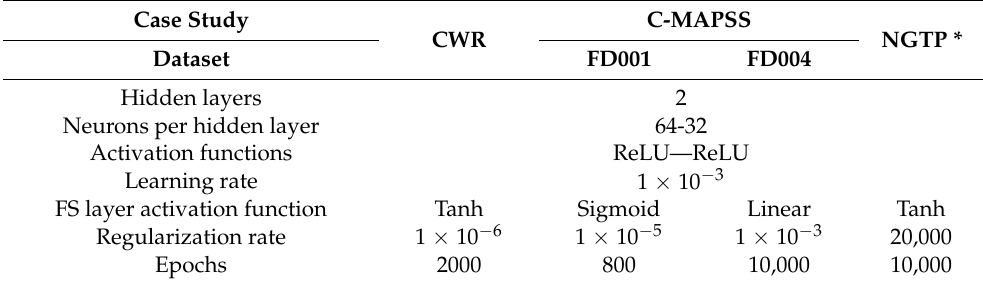
Table 8. Configuration of the four trained models.